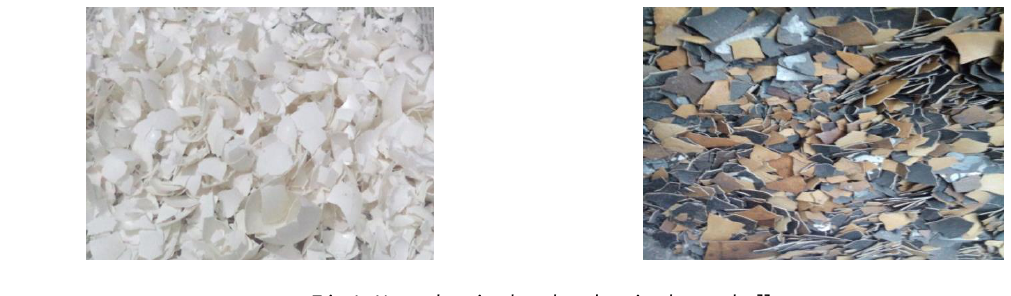
Fig.1. Uncarbonized and carbonized egg shells